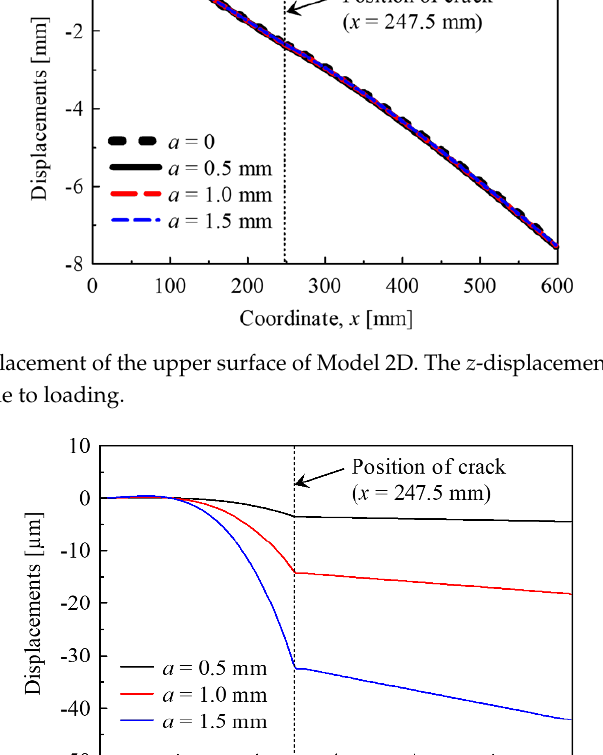
Figure 5. The di ff erence in the z -displacement between the models with and without a crack.